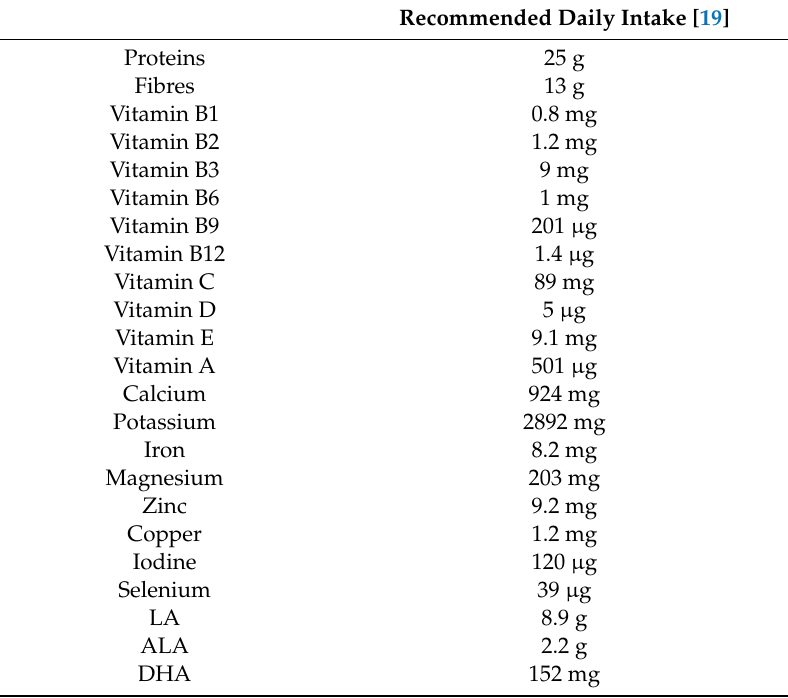
Table A1. Recommended daily intakes of “protective” nutrients (proteins, fibres, essential fatty acids, vitamins and minerals) for French children of primary school